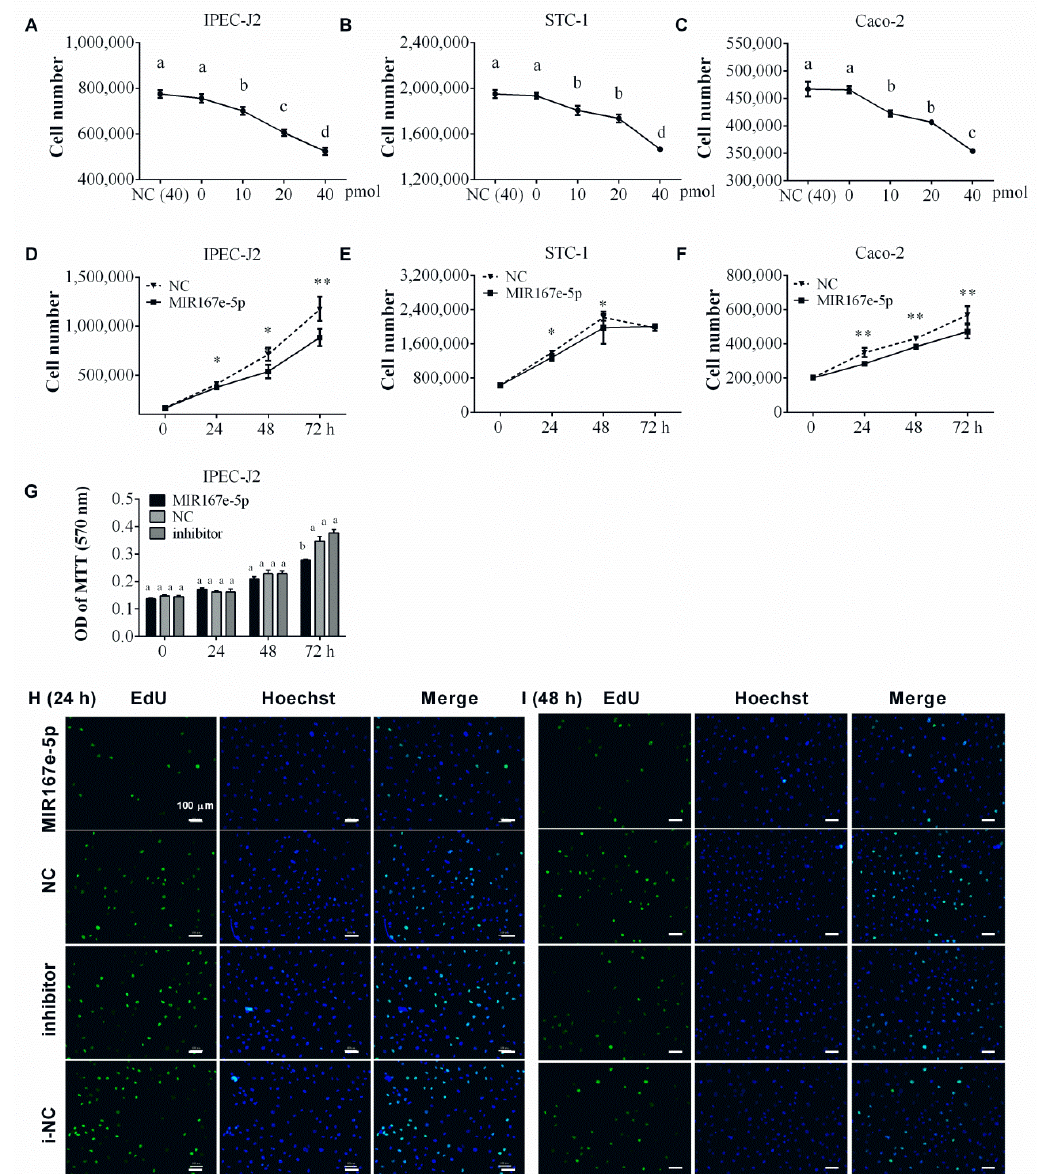
Figure 1. Synthetic MIR167e-5p suppresses the proliferation of IPEC-J2, STC-1, and Caco-2 cells. ( A – C ) Number of IPEC-J2 ( A ), STC-1 ( B ), and Caco-2 ( C ) cells transfected with different doses of MIR167e-5p ( n = 6, LSD tests). ( D – F ) IPEC-J2 ( D ), STC-1 ( E ), and Caco-2 ( F ) cells proliferation